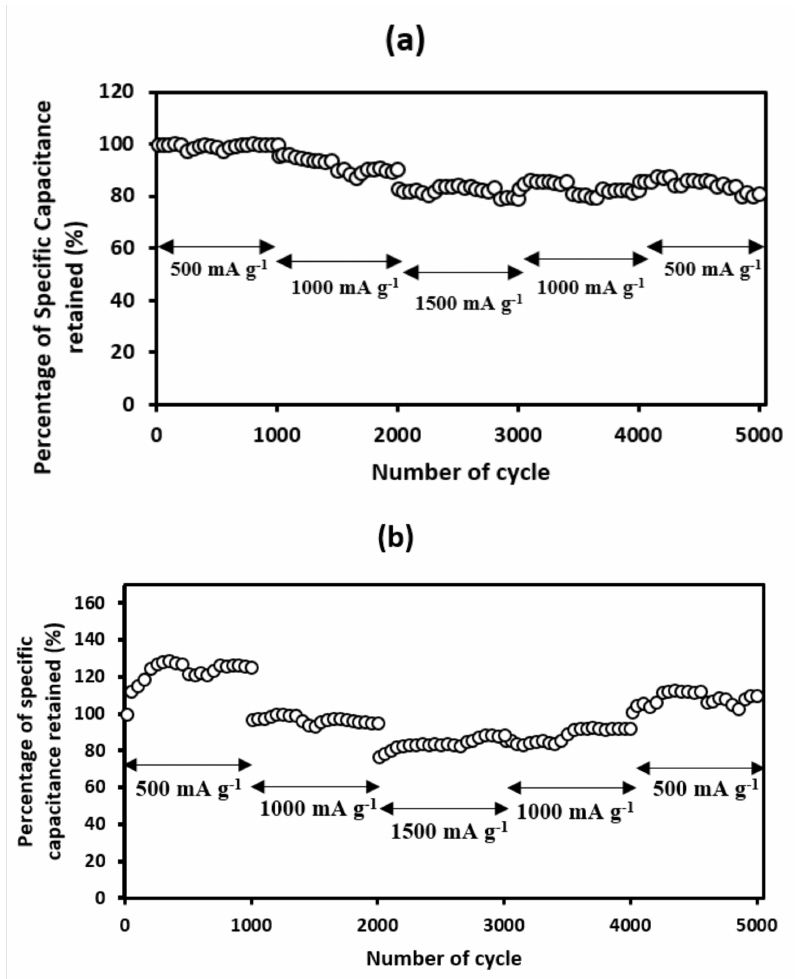
Figure 11. Rate capability plot for ( a ) CN-R and ( b )